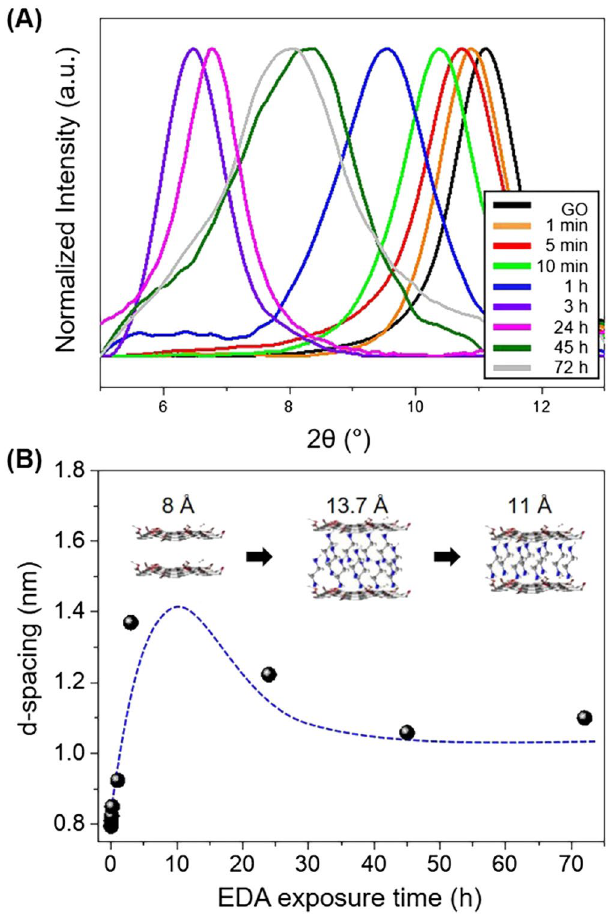
Figure 3. ( A ) XRD patterns of GO/EDA as a function of EDA vapor exposure time. ( B ) Corresponding d-spacing of